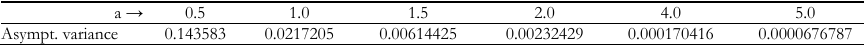
Asymptotic variance for the test statistic S n,a with parameter a a